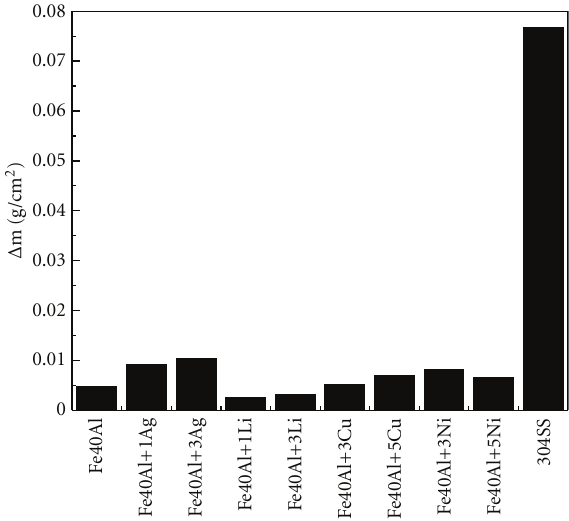
Figure 2: E ff ect of Ag on the polarization curve for Fe40Al alloy in NaCl-KCl (1:1 molar ratio) salt in static air at 670 ◦ C.